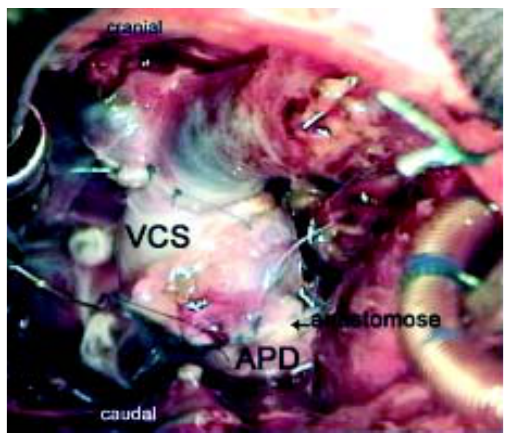
Fig. 1 - Aspecto do campo operatório. Anastomose da veia cava superior na artéria pulmonar